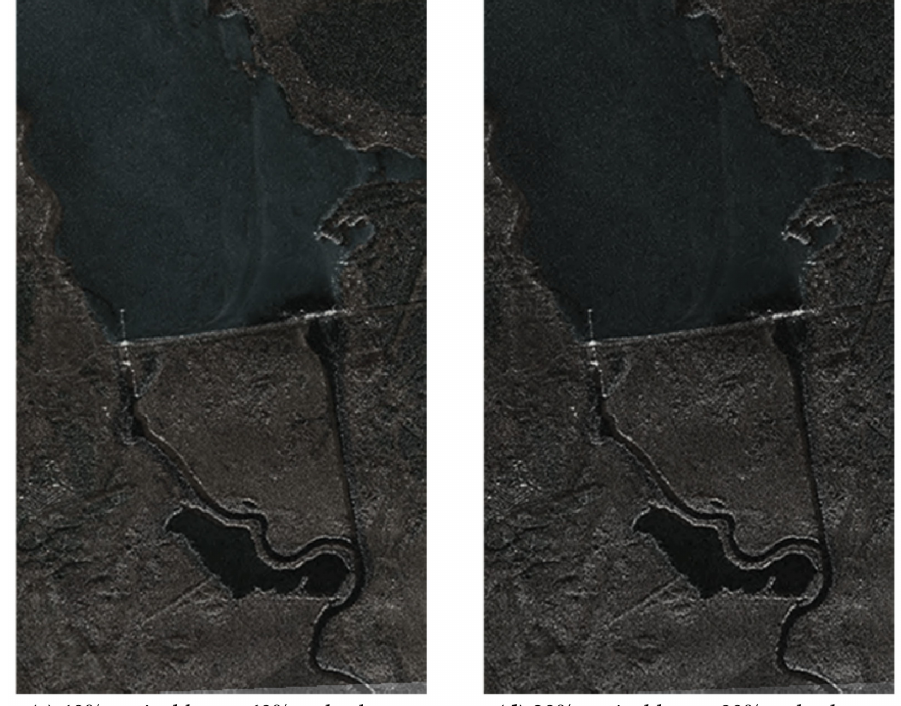
Figure 13. A series of fused images with varying degrees of enhancement of the radar or optical